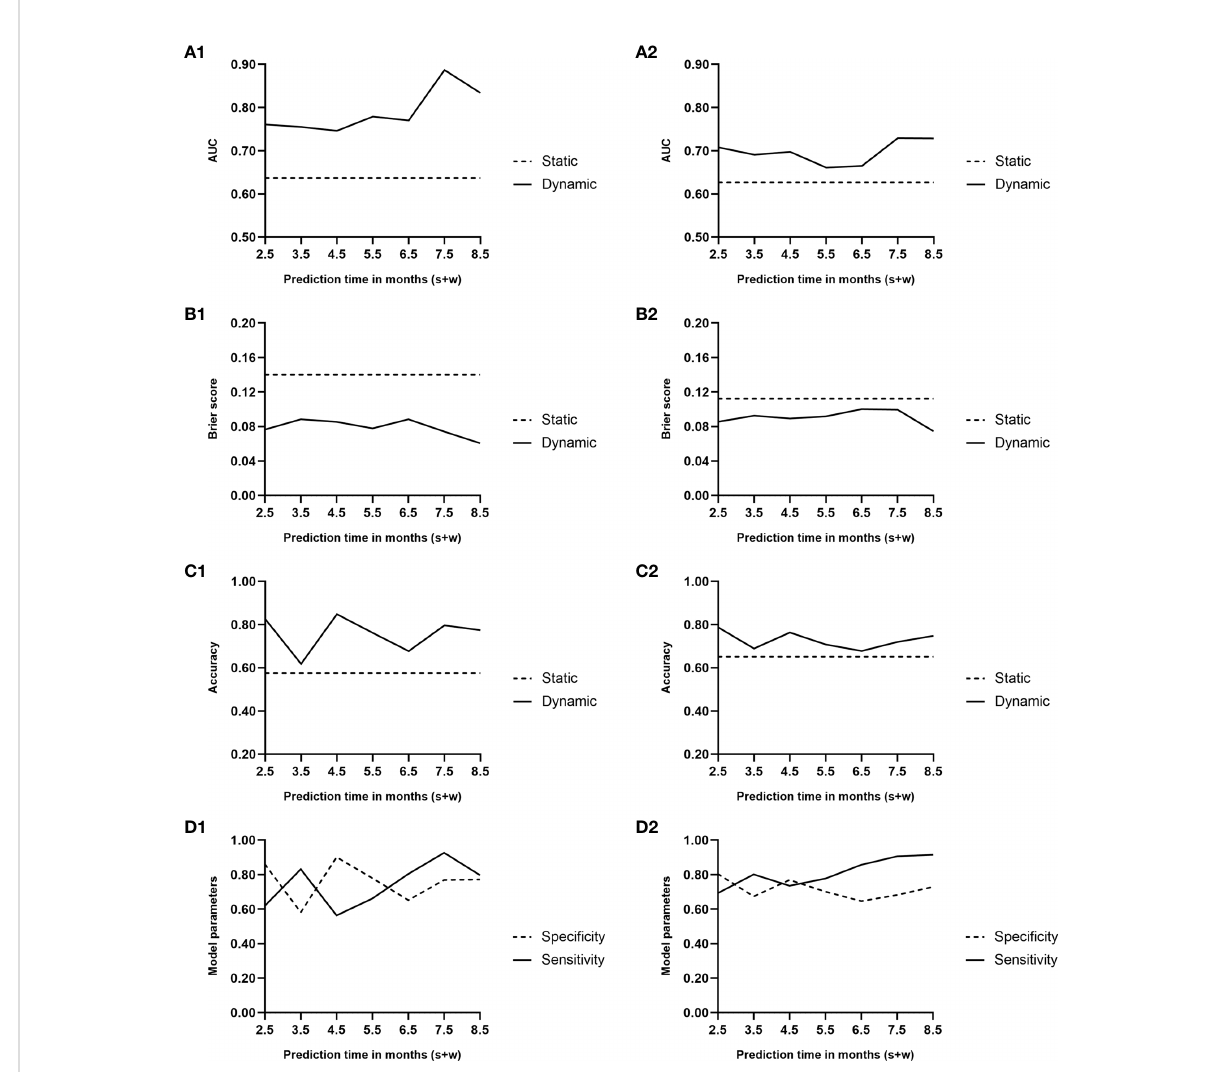
FIGURE 4 Area under the curve (A1, A2) , Brier score curve (B1, B2) , and accuracy curve (C1, C2) during the predicted period of the two models. Solid lines, dynamic model; dashed lines, static model. (D1, D2) Sensitivity and speci fi city curves during the predicted period of the dynamic model. Solid line, sensitivity; dashed line, speci fi city; 1, performance of the two models; 2, results of the Monte Carlo